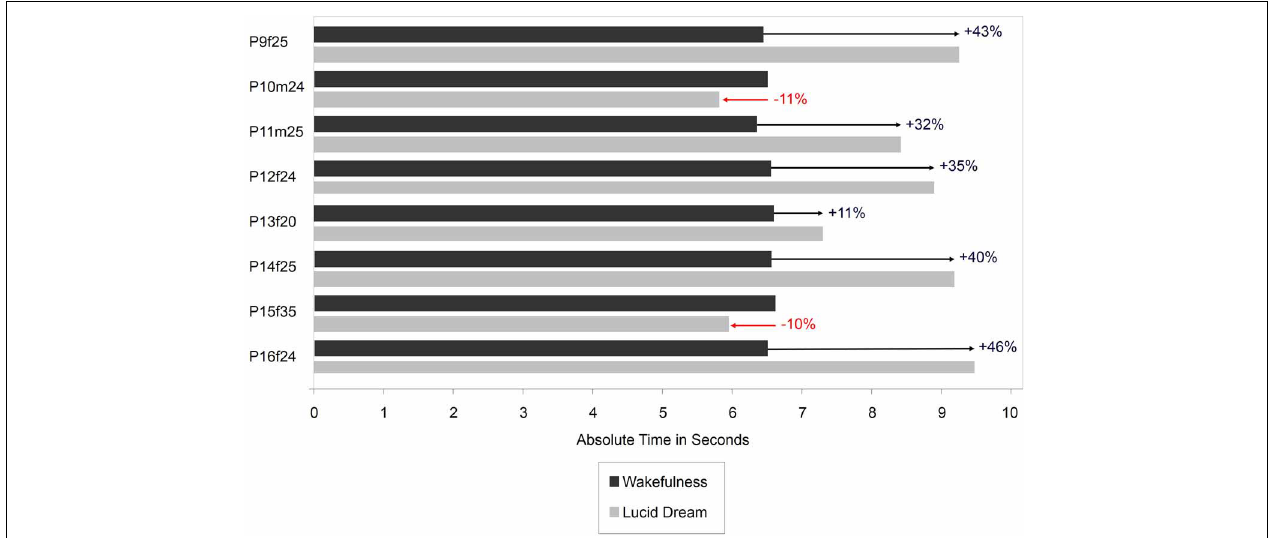
FIGURE 7 | Absolute durations of the gymnastic routing during wakefulness and lucid dreaming (Labels: e.g., P1f25 = Participant 1, female, 25 years).